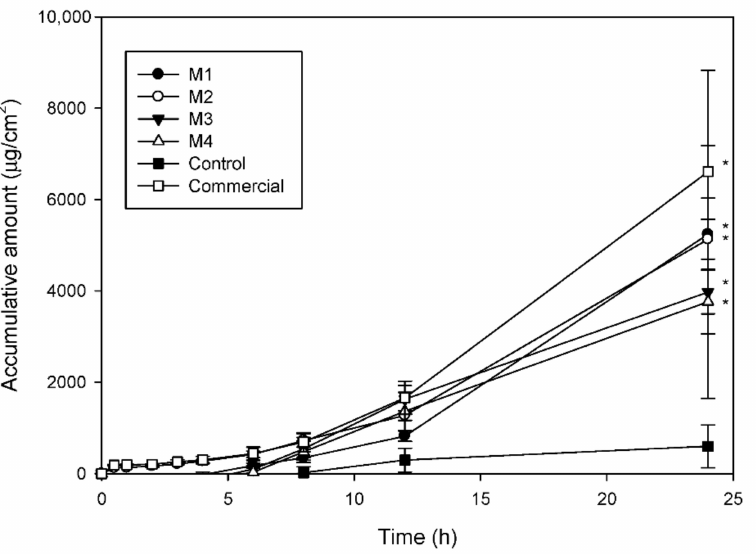
Figure 1. In vitro penetration-time profile of 5% azelaic acid-loaded formulations and control solution containing 5% drug and 30% ethanol through rat skin.* significant difference when compared with control